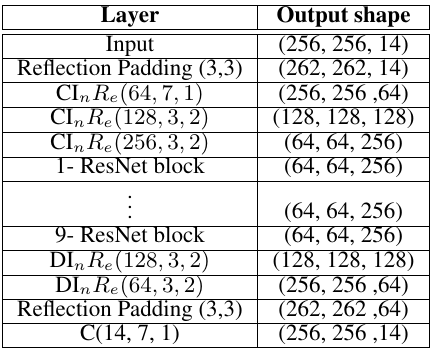
Figure 1. Images of study area in color composition (NIR, G, B). (a) to (d) Images from 2016 and 2019 respectively. (e) to (g) Deforestation maps provided by PRODES project.